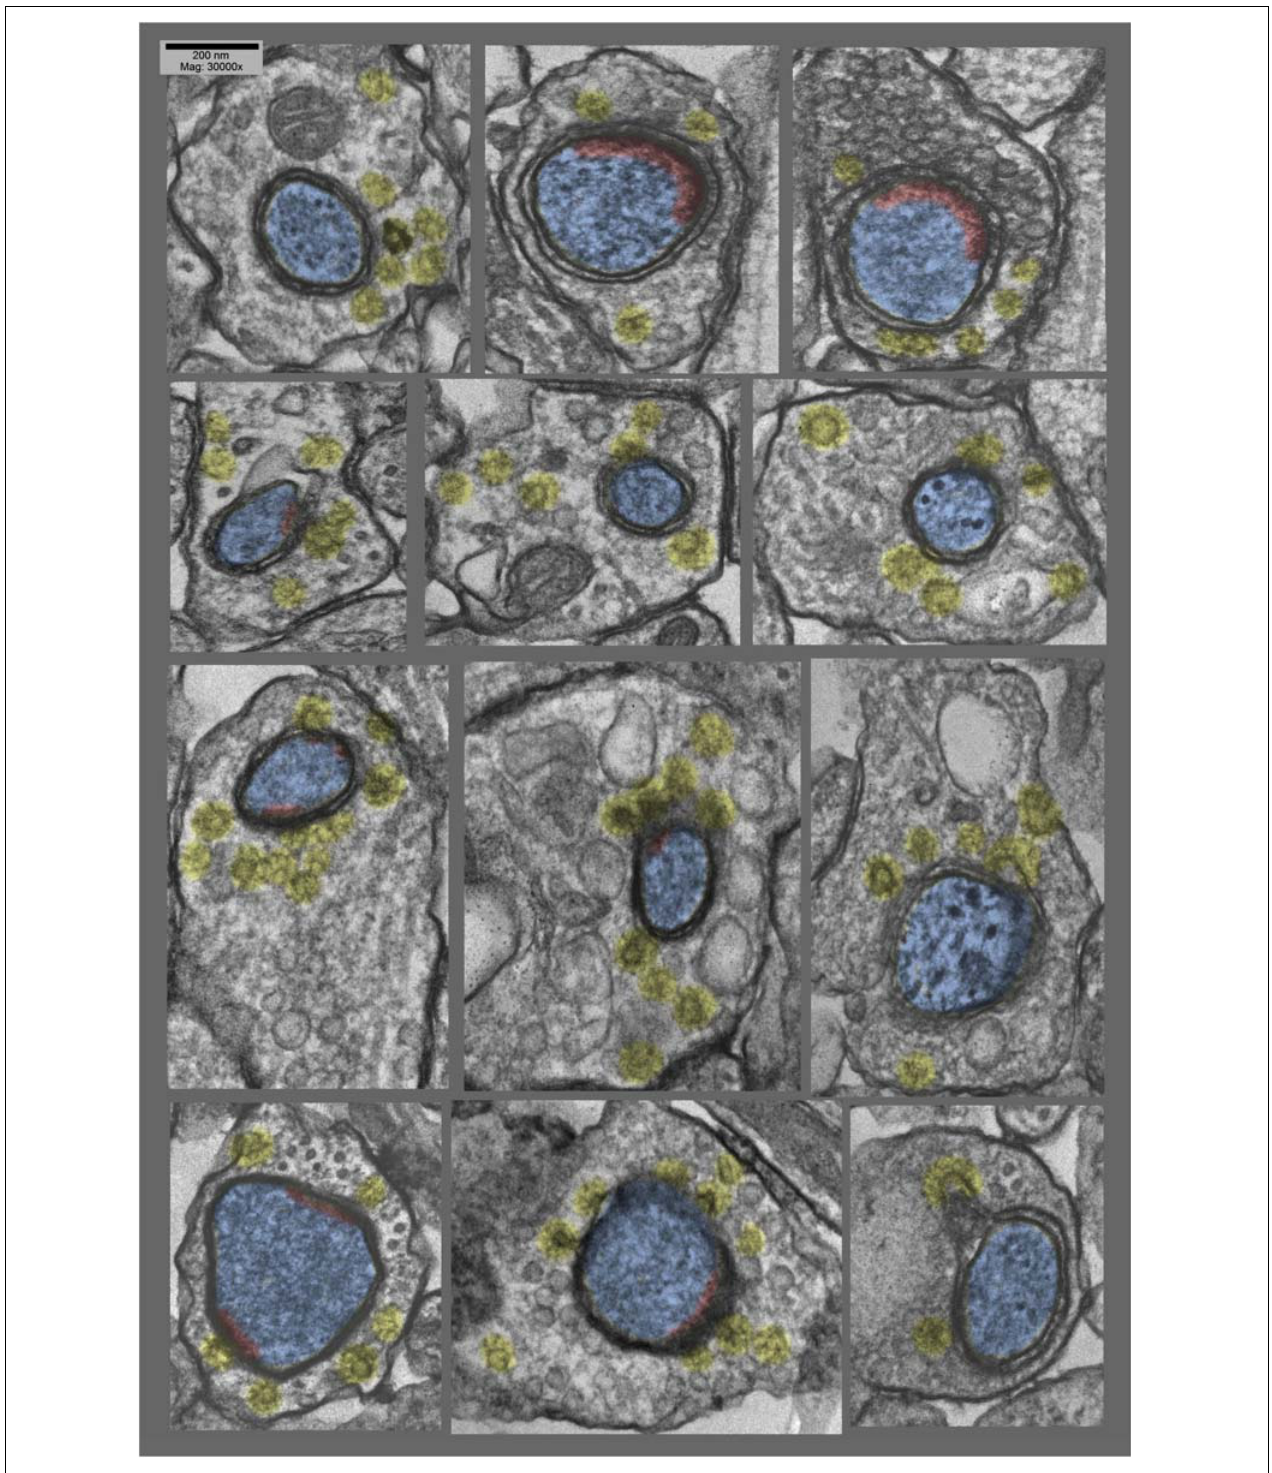
FIGURE 4 | Montage of cross sections of several other postsynaptic “protrusions” or presynaptic “hugs,” from the same hippocampal cultures as in Figure 3 (exposed to 0.1 mM La +++ for 10–20 min at 37 ◦ C). Again, it is quite apparent that synaptic vesicles are more or less depleted, compared with the relative abundance of clathrin-coated vesicles (highlighted in yellow). Again, PSDs (highlighted in red) appear to be relatively fragmented or absent from these deeper regions of the postsynaptic involutions.